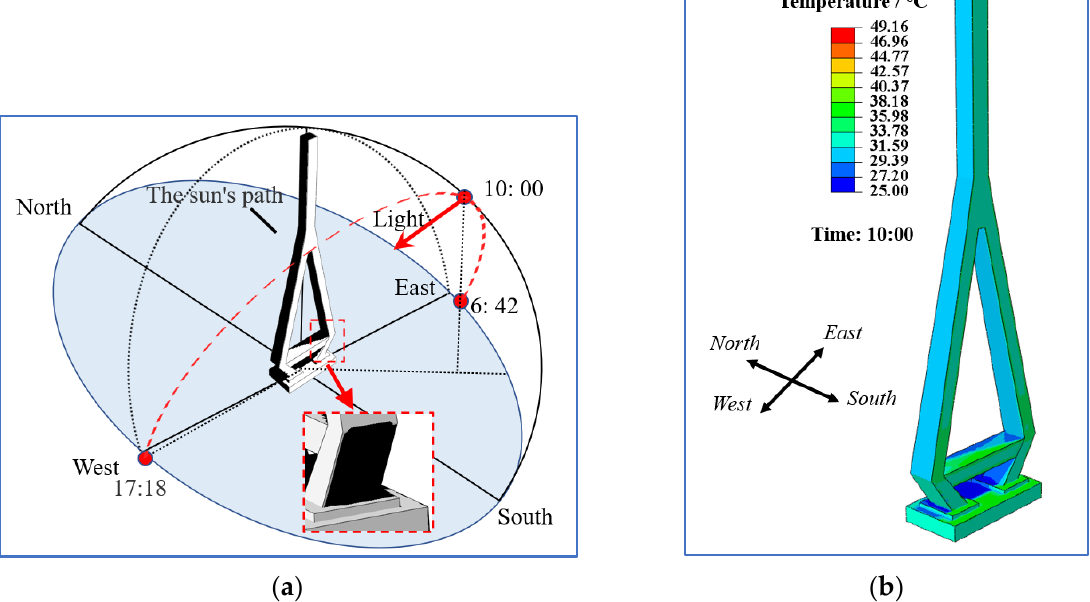
Figure 19. Shadow occlusion state and temperature field cloud of the bridge tower at 10:00 a.m. ( a ) The shaded state of the bridge tower surface; ( b ) the temperature field cloud map.